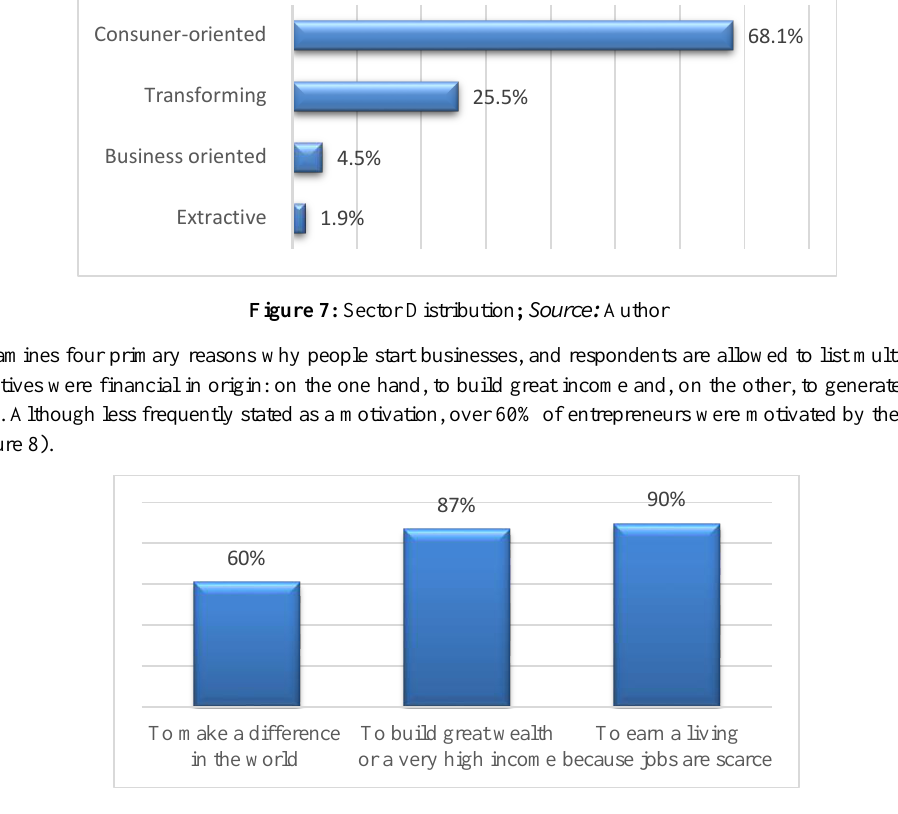
Figure 8: Entrepreneurial Motivations ; Source: